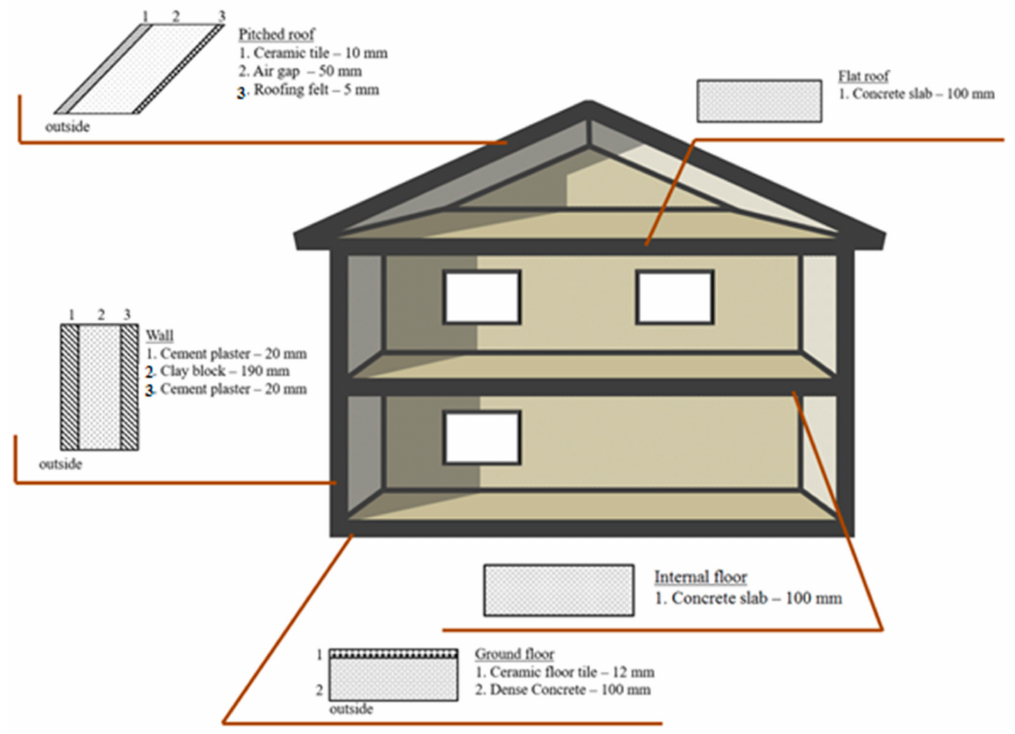
Figure 3. Schematic illustration of the building